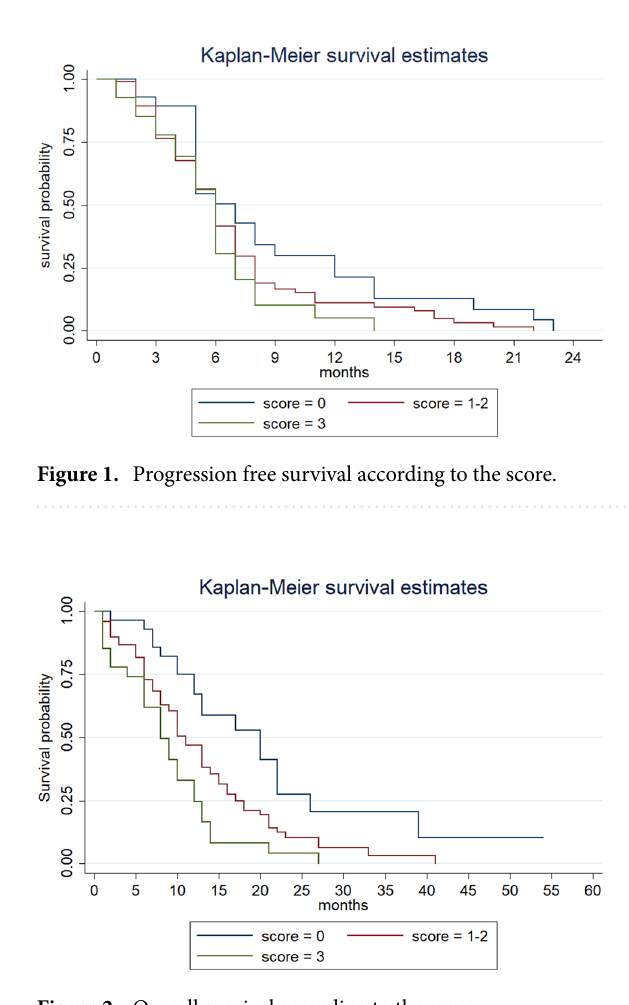
Figure 2. Overall survival according to the